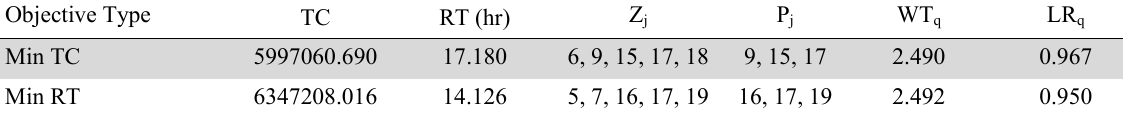
Results of solving the model by each of the objective functions separately